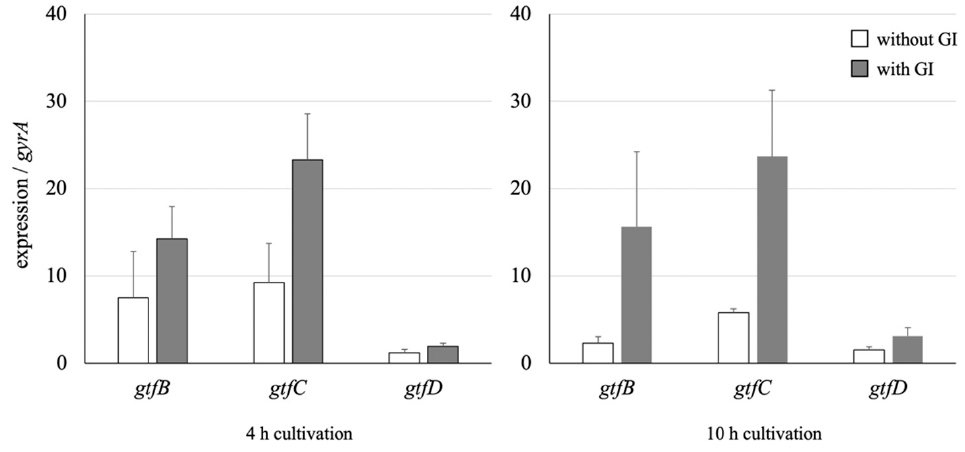
Figure 3. Expression differences of three gtf genes with or without the GI fraction. The data were corrected from the S. mutans cells cultured in the absence or presence of a GI fraction. The results were normalized to the housekeeping gene ( gyrA ). The data are indicated as means of independent assays with a standard error.